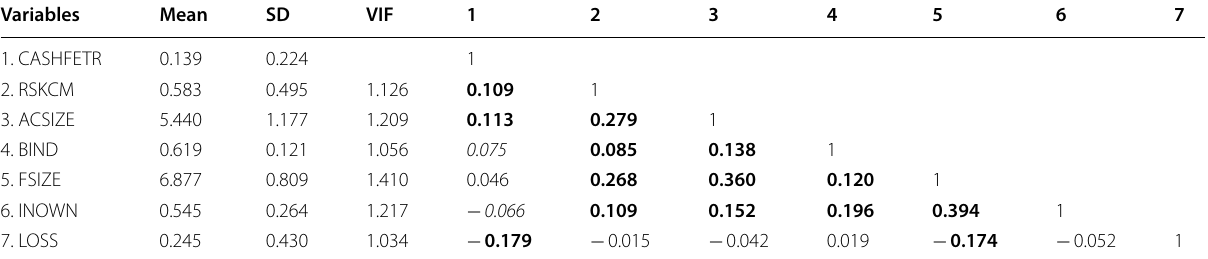
Table 3 Descriptive and correlation analysis for all variables. Source : Researcher’s compilation (2022)